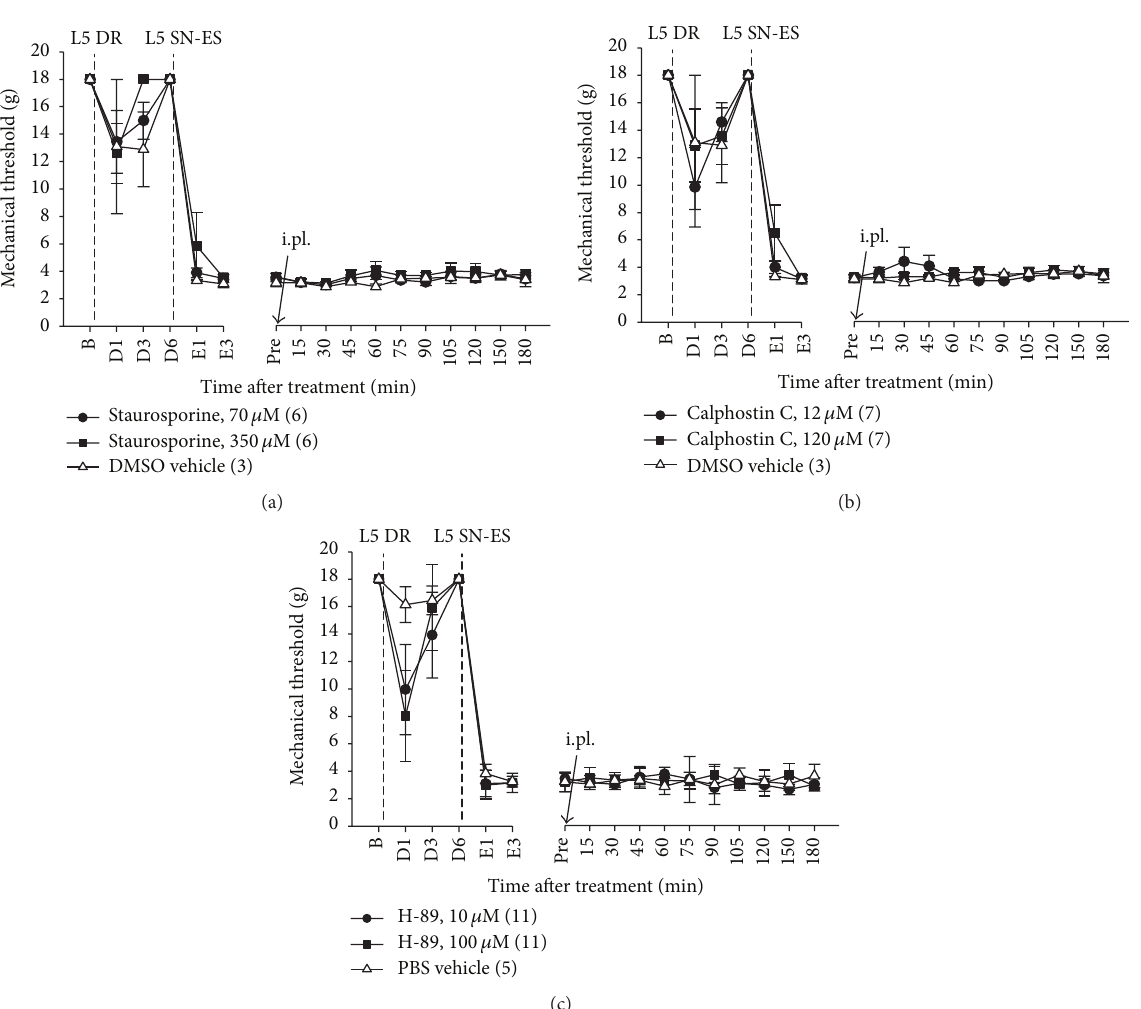
Figure 6: Effects of staurosporine, calphostin C, or H-89 posttreatment in the periphery on ES-induced PWT reduction. (a–c) In rats with L5 DR, an i.pl. injection of staurosporine (70 𝜇 M), calphostin C (12 𝜇 M), or H-89 (10 𝜇 M) administered 3 days after the ES of L5 SN (L5 SN- ES) into the midpoint of the L4 plantar dermatome resulted in no significant difference in ES-induced decreased PWTs from vehicle-treated controls. No effects were observed with higher doses of each drug. The abbreviations B, D, E, and Pre are defined in Figure 4. The values in parentheses indicate the number of animals used. The error bars represent the